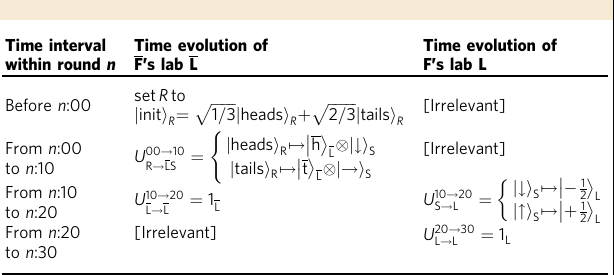
Table 1 Time evolution Time interval within round n